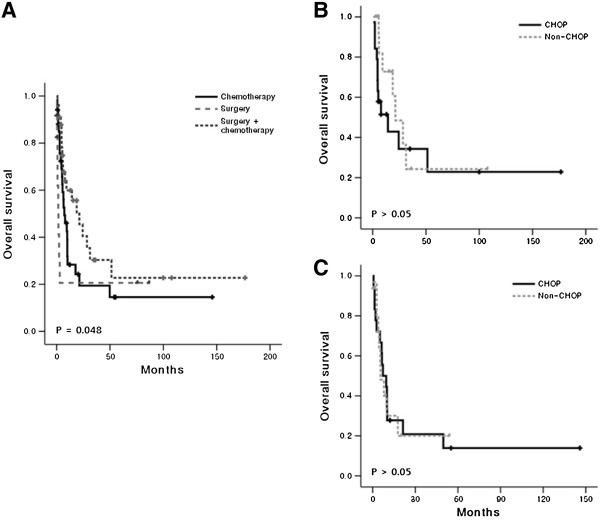
Analysis of survival outcomes based on treatments. (A) The comparison of overall survival shows better survival of patients treated with surgery plus chemotherapy with marginal significance compared to chemotherapy alone. (B) The comparison of overall survival according to the type of chemotherapy regimen, CHOP versus non-anthracycline based chemotherapy (non-CHOP) shows no difference in the surgery plus chemotherapy group. (C) In the chemotherapy group, there is no difference between CHOP and non-CHOP regimens.